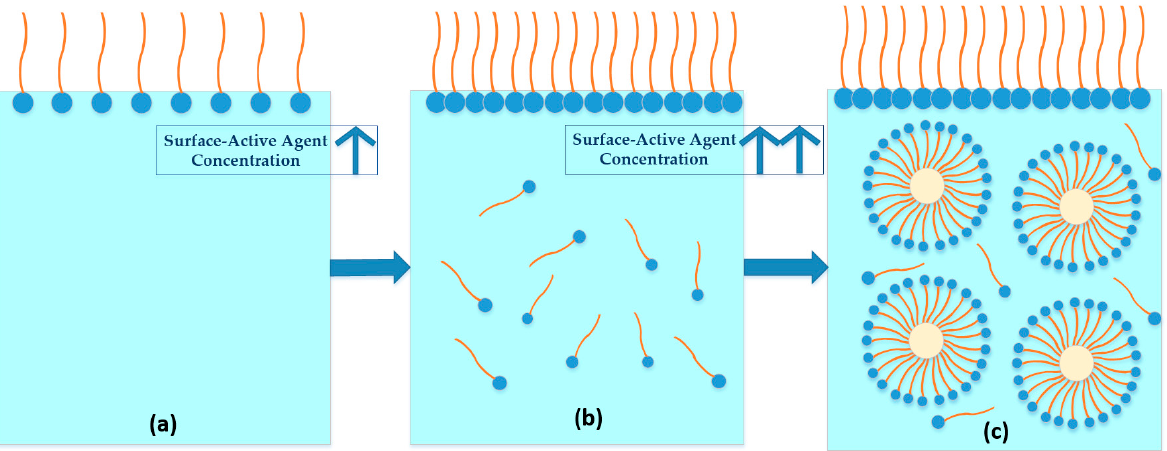
Figure 2. Surfactant micelle formation in water, modified from [44]. ( a ) Surfactants reduce the surface tension of water by adsorbing at the liquid-gas interface. ( b ) As the surfactant concentration continue to increase, surfactant molecules saturate the interface and they start moving in water in the form of monomers. ( c ) When the surfactant concentration reaches CMC, micelle formation takes place, which improves the aqueous solubility of otherwise insoluble NAPLs.